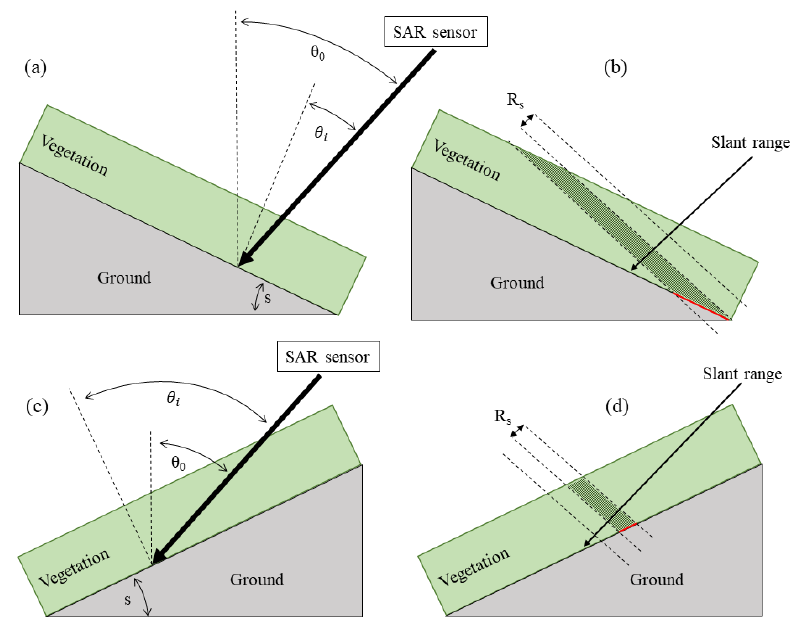
Figure 4. Effect of steep slopes on InSAR signal. ( a ) Where slopes face towards the sensor, the local incidence angle θ i becomes small. ( b ) Considering the range resolution of the sensor R S , each resolution cell contains an excessive volume of vegetation and an extended area of ground, leading to poor angular coherence in the scattered signal. The opposite case is shown in ( c ) where the slope faces away from the sensor, leading to large θ i . ( d ) For the same R S , fewer scattering components are present in each resolution